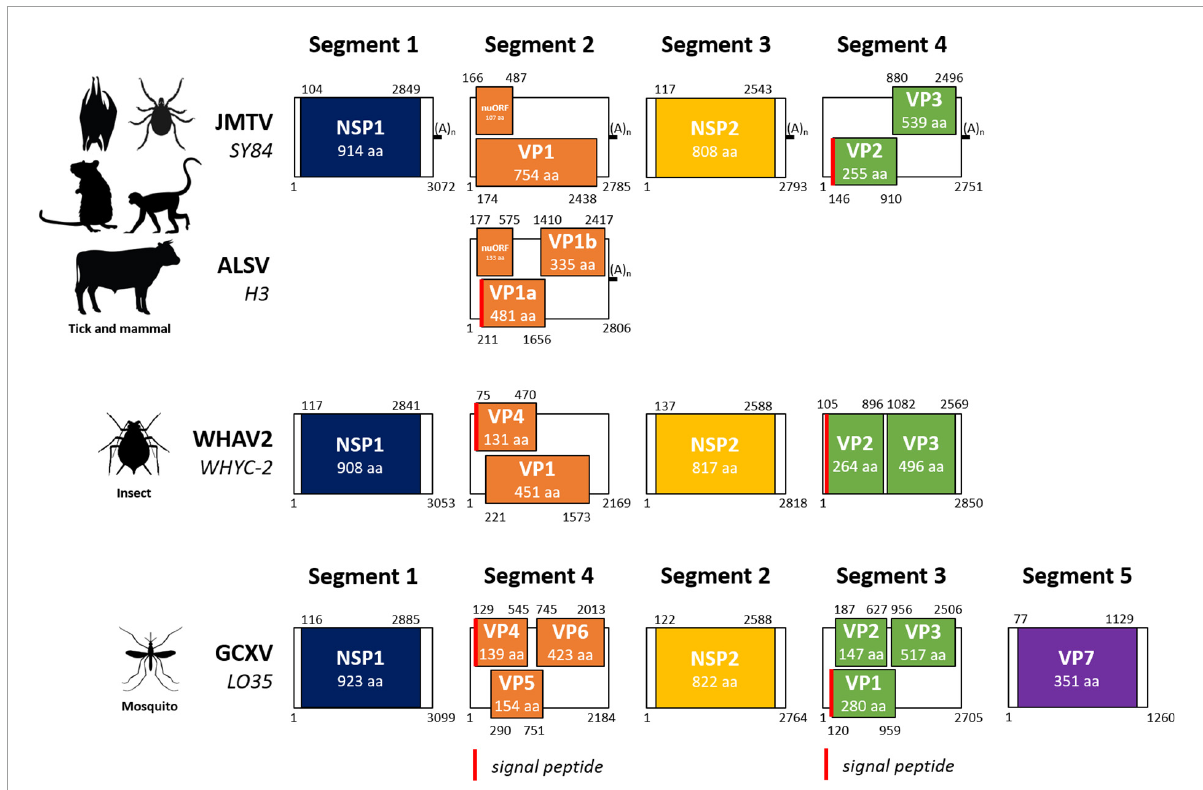
FIGURE1 Genome organization of jingmenviruses. The layout of this figure is modified from Kobayashi et al. (2021). JMTV SY84, Jingmen tick virus strain SY84 (NC_024113-NC_024117); ALSV H3, Alongshan virus strain H3 (MH158415–MH158418); WHAV2 WHYC-2, Wuhan aphid virus 2 strain WHYC-2 (KR902725–KR902728); GCXV LO35, Guaico Culex virus strain LO35 (KM461666-KM461670). (A) n , polyadenylation. NSP1, non-structural protein 1, RNA-dependent RNA polymerase and methyltransferase domains; VP, virus (structural) protein; nuORF, open reading frame identified by Kholodilov et al. (2020); NSP2, non-structural protein 2, serine protease and helicase domains. Red bar: signal peptide. The genome organization of JMTV and ALSV are representative of tick- and mammal-associated jingmenviruses; WHAV2 represents insect-associated jingmenviruses; GCXV represents mosquito-associated